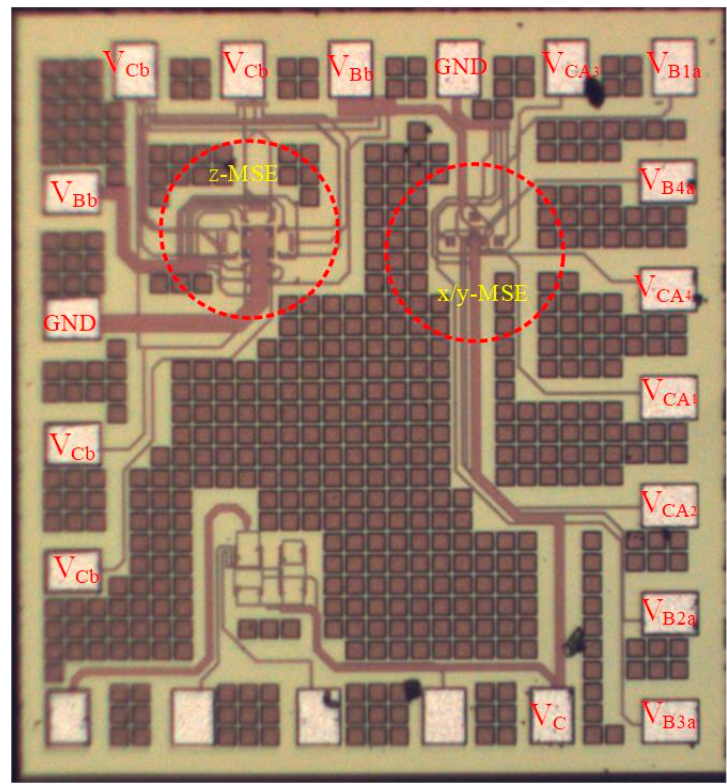
Figure 9. Picture of the MS chip.